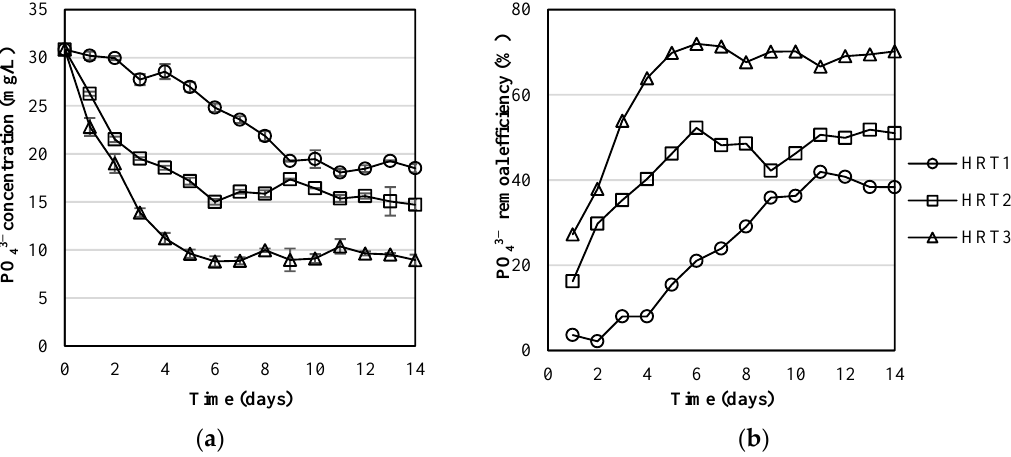
Figure 4. The change of ( a ) PO 43 − concentration and ( b ) PO 43 − removal efficiency in 2-fold diluted piggery wastewater over 14 days in Chlorella vulgaris -based MPBR at various hydraulic retention times (HRT1 = 1.25 days, HRT2 = 2.5 days, HRT 3 = 5 days). The COD removal ability of C. vulgaris in the MPBR was also investigated in this study. The variation and the removal efficiency of the COD concentration in the outlet stream of the system are described in Figure 5. At the hydraulic retention time of 5 days, the COD reduction was rapid in the first 5 days, dropping from 287 mg/L to 127 mg/L (reaching 55.37% of COD removal efficiency). This was the same period of the exponential phase of microalgae growth, at which the culture largely consumed the nutrient and car- bon source. In contrast, the reduction of COD at shorter HRT was at a much slower pace (9.75% and 15.85%) during the same period for 1.25 days and 2.5 days. It required a longer period for the COD removal efficiency to reach a stable state (around 25% and 40% for HRT1 and HRT2, respectively) than that of HRT 3. At the final stage of the experiment, the COD concentrations in the output stream were 227.05 mg/L, 182.95 mg/L, and 97.90 mg/L (corresponding to 20.81%, 36.19%, and 65.85% of COD removal efficiency) for HRT1, HRT2, and HRT3, respectively.